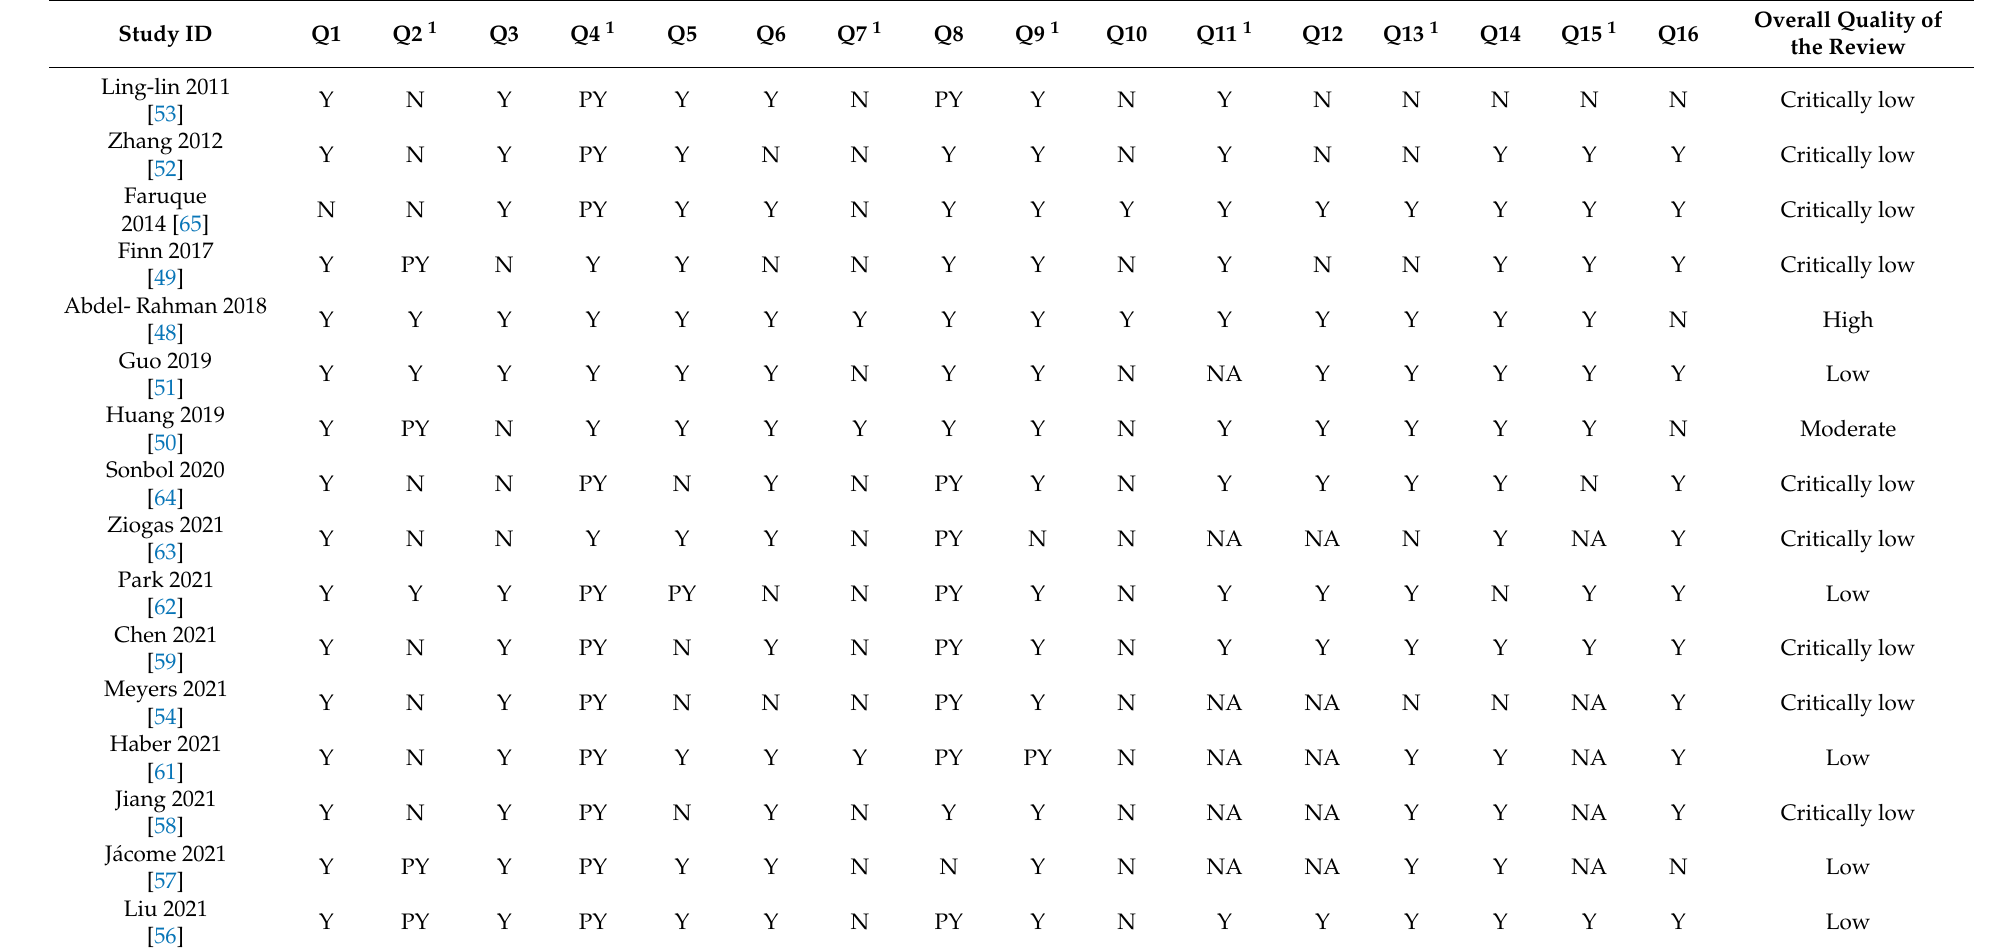
Table 2. Quality assessment of the included reviews according to